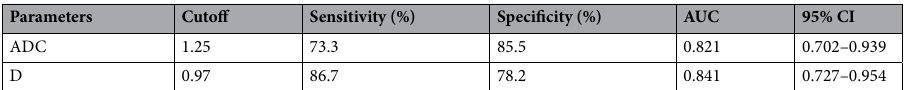
Table 2. The efficacy of IVIM parameters for distinguishing well differentiated HCC from moderately and poorly differentiated HCC. CI confidence interval.